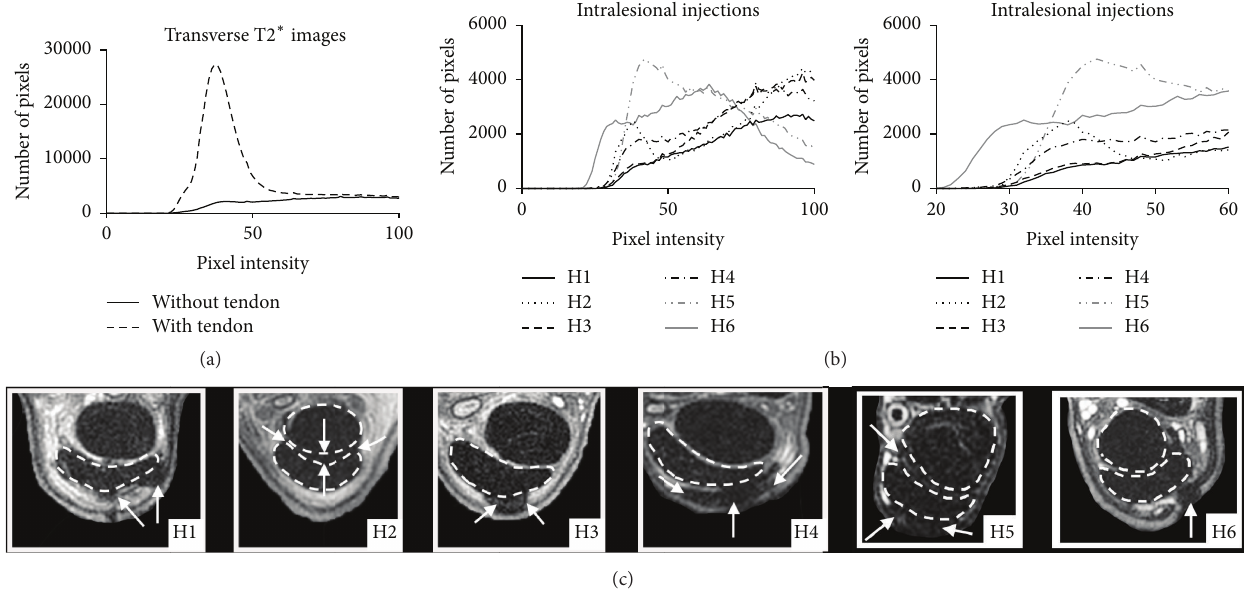
Figure 9: Transverse MRI of SDFT and quantification of low MRI signal as measured on 8-bit, grayscale images. (a) Graph showing summation of low signal intensity pixels before and after subtraction of DDFT and SDFT from transverse images. (b) Summation of low signal intensity pixels in the subcutaneous and surrounding soft tissues in all 6 subjects with a magnified view of the x -axis displayed on the right.(c)TRUFIimagesdemonstratingsubstantialeffluxofcellsintotheparatendinousandsurroundingtissues.Arrowsindicatehypointense areas of MRI signal representative of SPIO-treated cells. Dotted lines estimate the boundaries of the SDFT and DDFT.